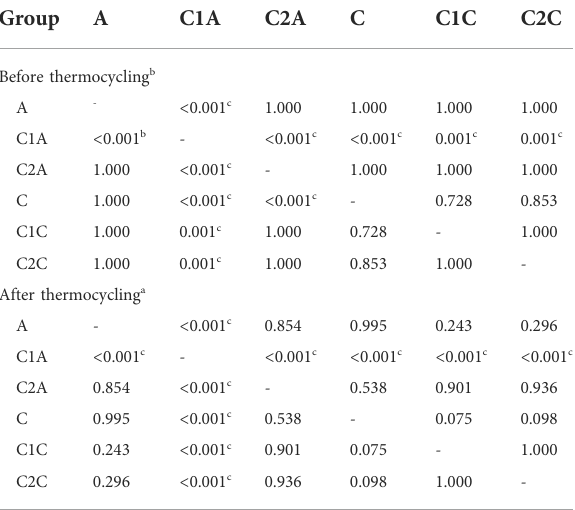
TABLE 2 Post hoc comparisons of the shear bond strength values for the bracket debonding before and after 10,000 thermocycles.